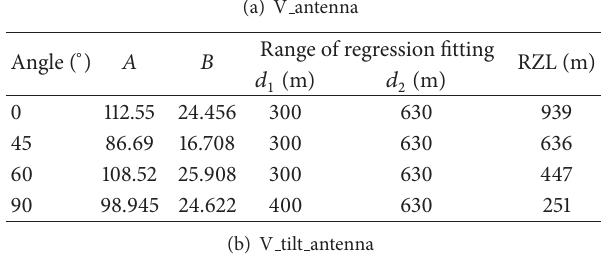
Table 4: Parameters of regression fitting